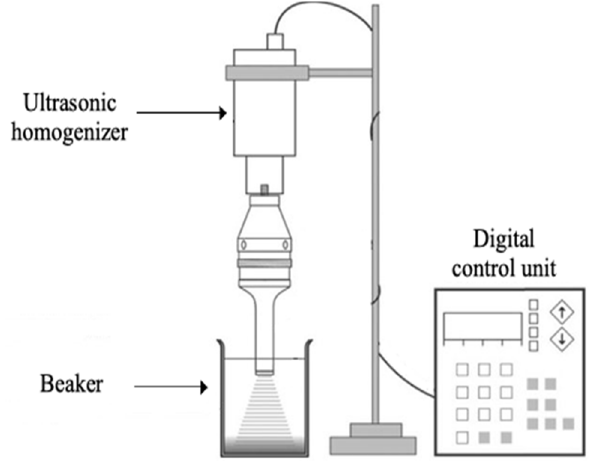
Figure 2. Ultrasonic treatment unit.